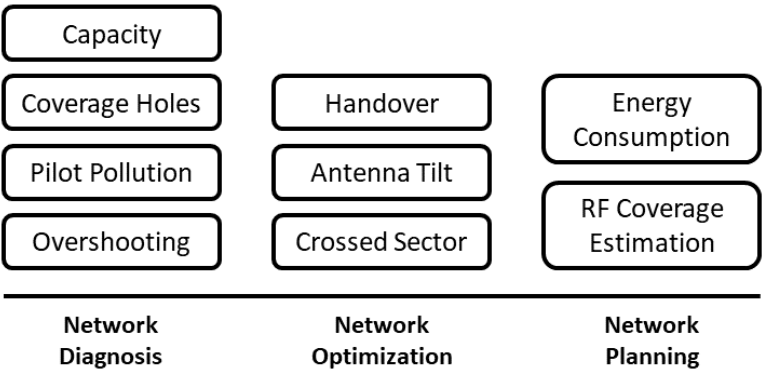
Figure 1. RAN automation